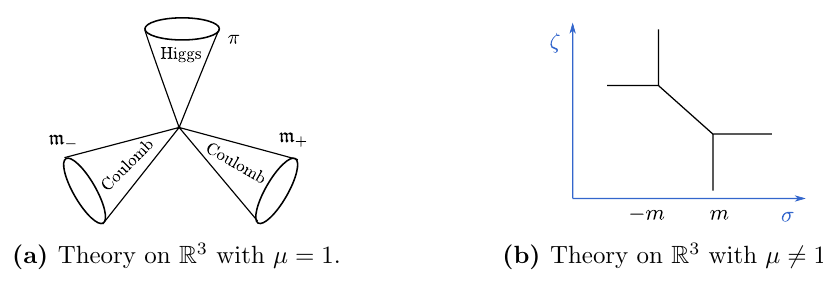
Figure 9. Vacua of N f = 1 SQED on R 3